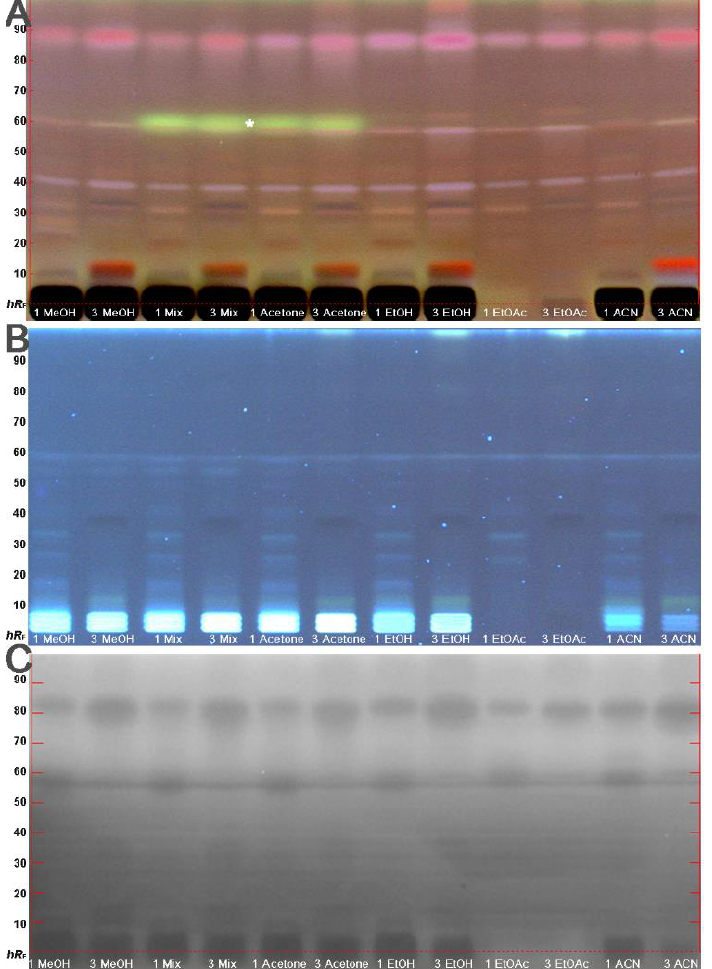
Figure 2. Investigation of different solvent selectivities for extraction: HPTLC chromatogram at FLD 366 nm after derivatization with anisaldehyde sulfuric acid reagent ( A ), at FLD 366 nm before the bioassay ( B ) and bioautogram after Aliivibrio fischeri bioassay, depicting bioluminescence after 30 min as grey scale image ( C ) of methanol (MeOH), mixture of methanol/acetone 1:1 (Mix), acetone, ethanol (EtOH), ethyl acetate (EtOAc) and acetonitrile (ACN) extracts of puree sample IDs 1 and 3 (Table 2, 0.4 g/mL) applied as area (6.0 × 3.0 mm, 10 µL/area), developed on HPTLC plates silica gel 60 F 254 with toluene – ethyl acetate – methanol – formic acid 2.4:1.8:0.7:0.06, V/V/V/V, in twin-trough chamber 20 x 10 cm (*yellow acetone-soluble contamination from plastic flask material).